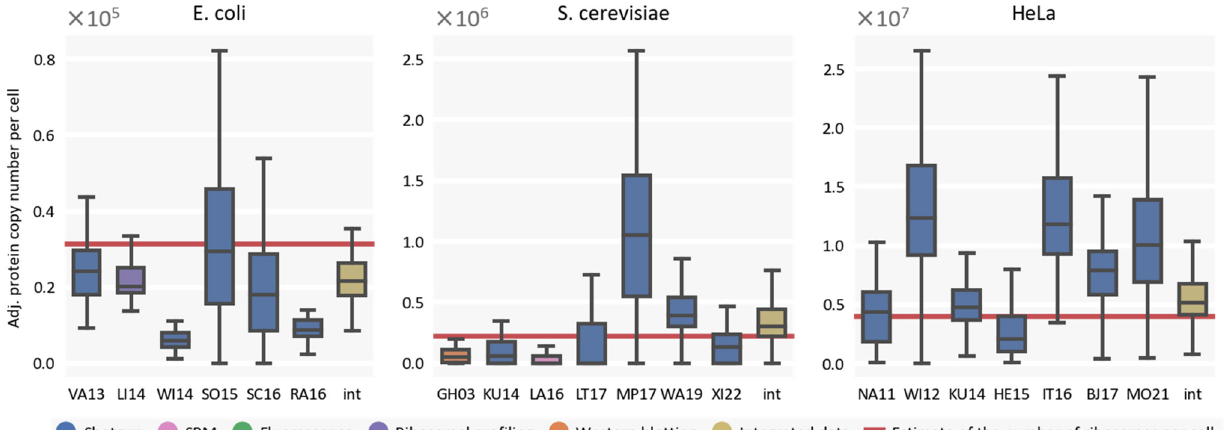
Figure 7. Distribution of adjusted copy numbers of ribosomal proteins in selected studies as well as in consensus proteomes. Adjusted protein copy number per cell denotes copy number of the ribosomal protein adjusted to the protein’s stoichiometry in the ribosome (see Section 4).